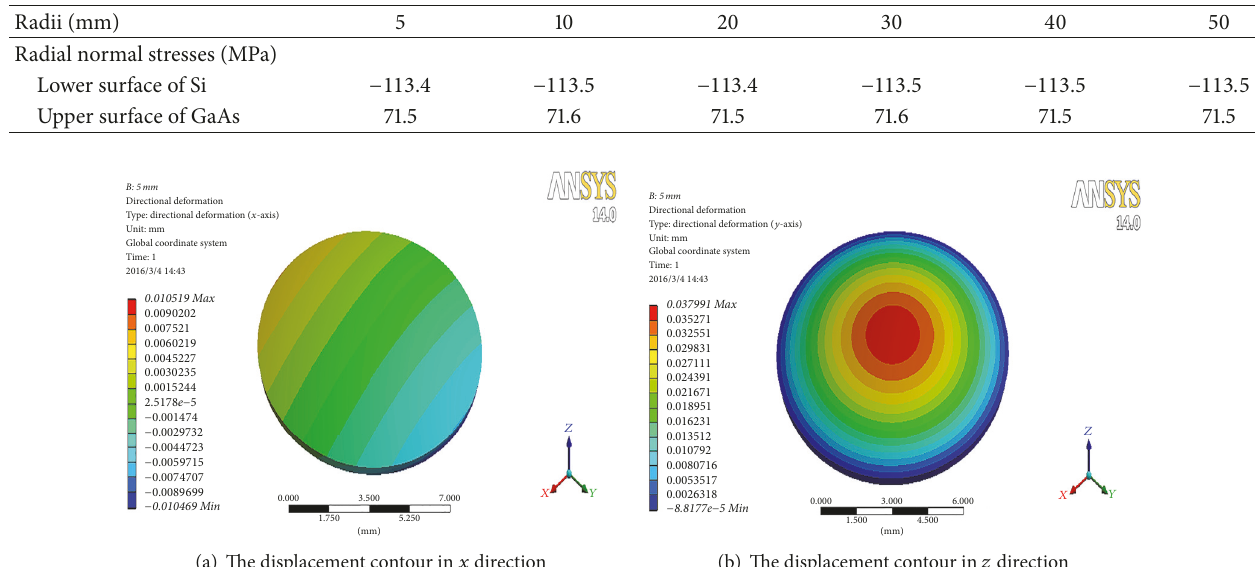
Figure 7: The displacement contours of the